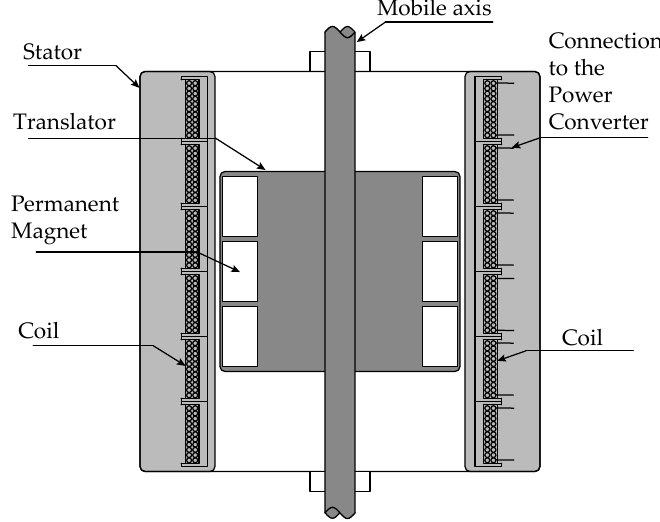
Figure 3. Tubular permanent magnet linear generator.